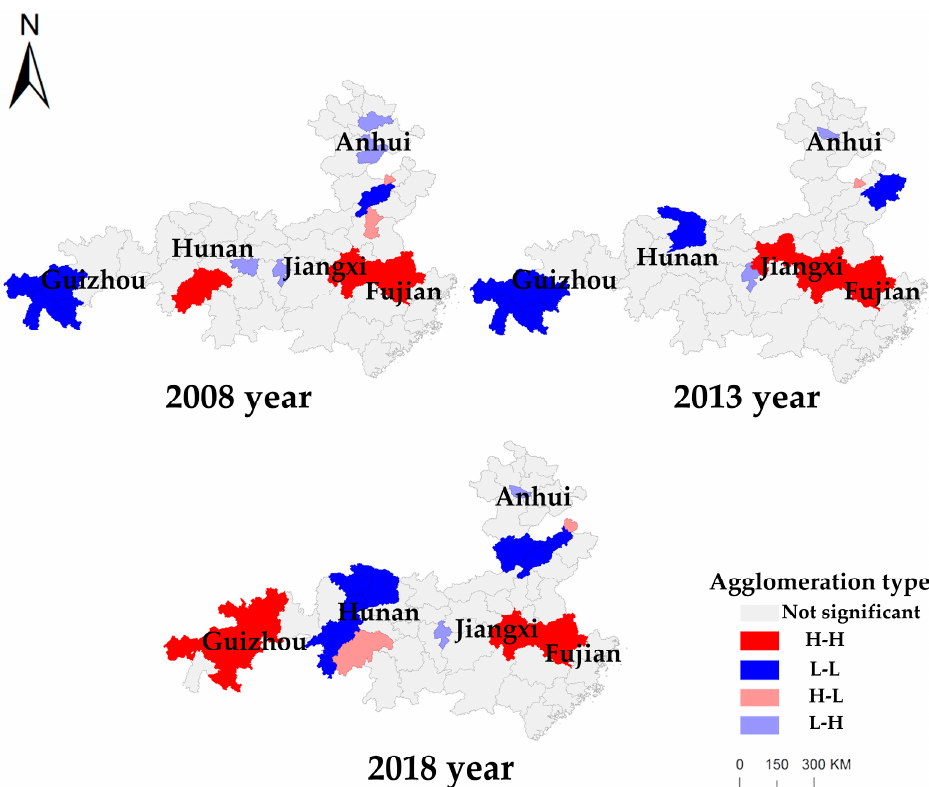
Figure 3. LISA cluster map of the CLUE in the study area from 2008 to